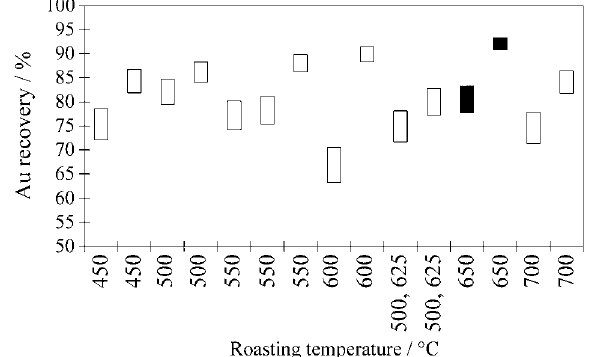
Figure 10. Mean gold recovery 95% confidence intervals from cyanida- tion tests with different roasted products.